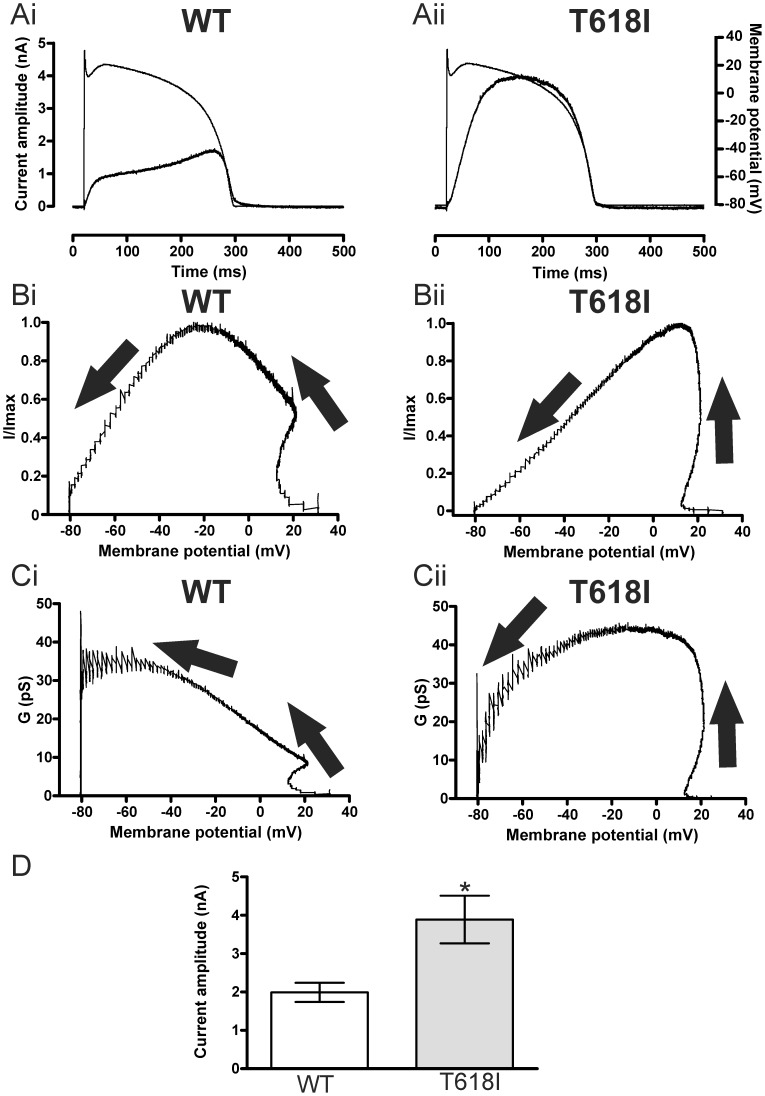
Action potential (AP) voltage clamp of WT and T618I IhERG.(A) IhERG (after p/4 subtraction) elicited by ventricular AP command for WT (Ai) and T618I (Aii) IhERG. Currents are shown overlaid with the voltage protocol. (B) Instantaneous I–V relations for IhERG elicited in A for WT (Bi) and T618I (Bii) IhERG. Current during the repolarising phase of the AP are plotted. Arrows denote direction of repolarisation. (C) Instantaneous conductance-voltage (G–V) relations for IhERG elicited in A for WT (Ci) and T618I (Cii) IhERG during AP repolarisation, Arrows denote direction of repolarisation. (D) Magnitude of peak repolarising current during AP voltage clamp, plotted for WT (n = 14) and T618I (n = 19) IhERG. * denotes statistically significant difference from WT at p<0.05.